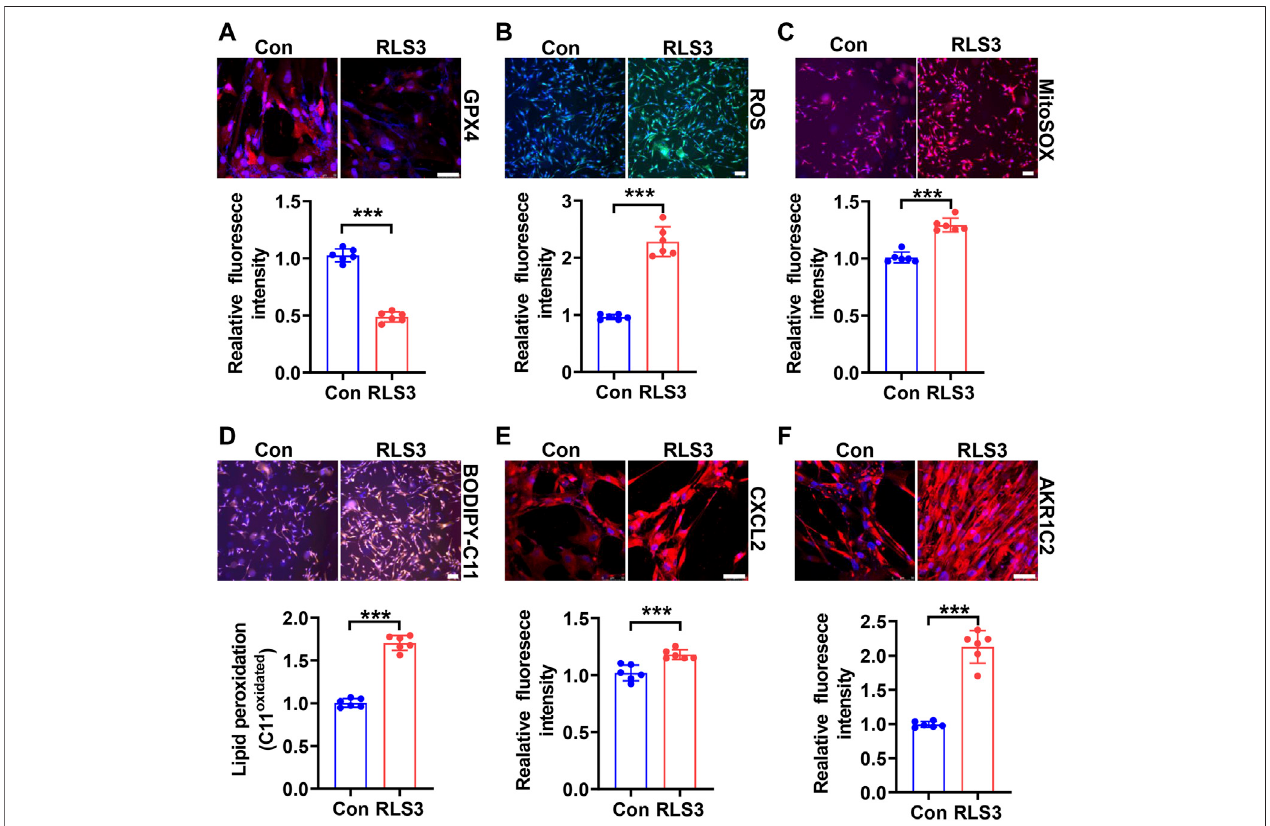
FIGURE 4 | Ferroptosis inducer RLS3 aggravates VSMC dysfunction in response to HHP. HASMCs were treated with RLS3 0.1 μ M for 6 h in the presence of 200 mmHg. Immuno fl uorescent staining of GPX4 (red) in HASMCs (A) . Intracellular ROS were measured by ROS staining; the upper panel is the representative image, and the lower panel is the statistical graph (B) . HASMCs were labeled with the MitoSOX Red probe to detect mitochondrial ROS (C) . Confocal images of the BODIPY 588/591 C11 staining; lipid oxidation was measured by the relative intensity of oxidized (orange fl uorescence signal) BODIPY 581/591 C11 (D) . CXCL2 (E) , and AKR1C2 (F) protein levels were detected by immuno fl uorescent staining. All scale bar = 50 μ M *** p < 0.001.